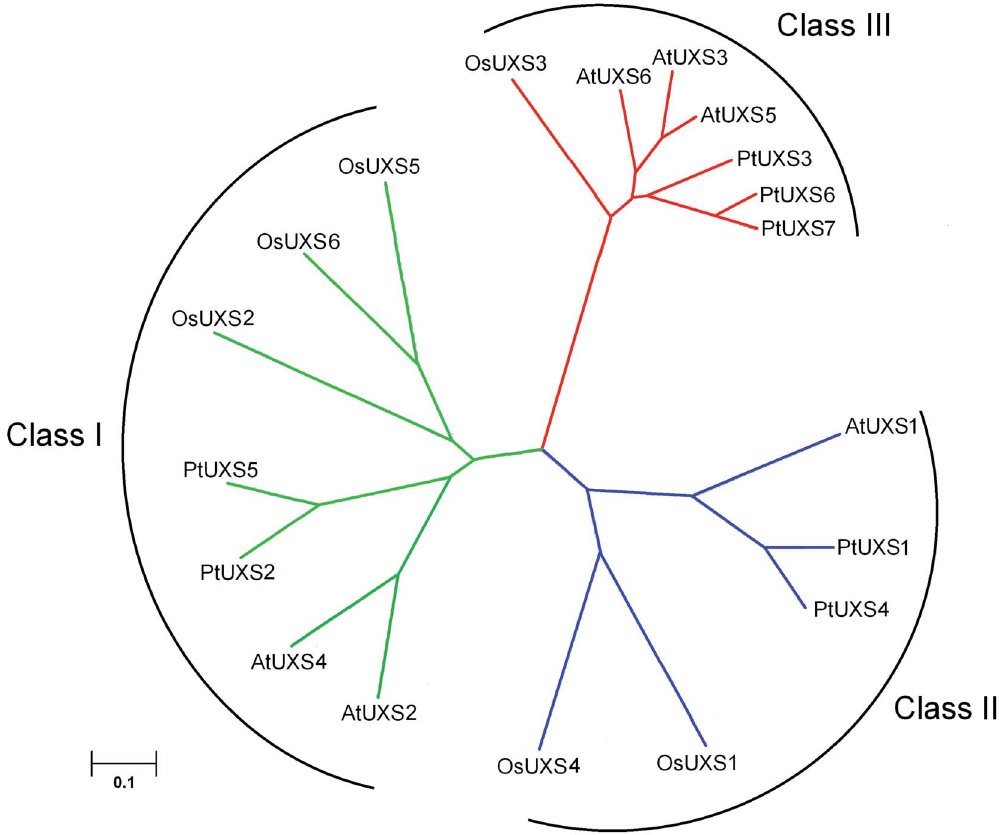
Figure 2. An unrooted phylogenetic tree of UXS members from poplar (PtUXS), Arabidopsis (AtUXS) and rice (OsUXS). Protein sequences of Arabidopsis UXS family members (AtUXSs) and rice UXS members (OsUXSs) were obtained from the (National Center for Biotechnology Information; http://blast.ncbi.nlm.nih.gov/Blast.cgi ). doi:10.1371/journal.pone.0060880.g002 PLOS ONE |